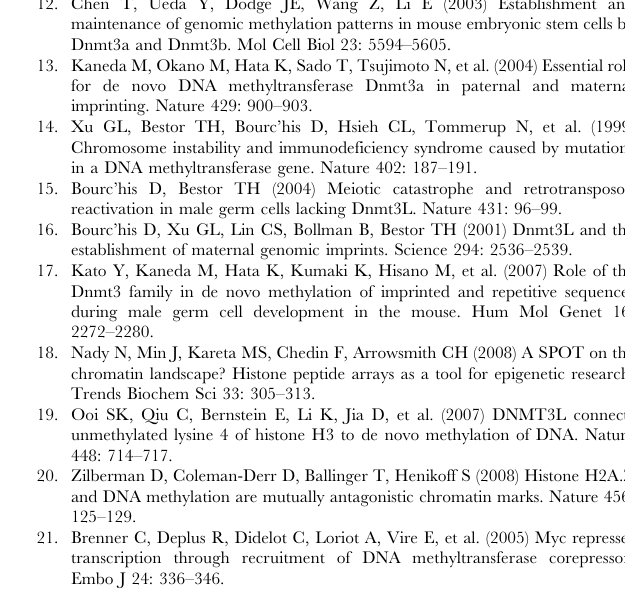
Figure S2 High and low methylation efficiency sites at the SNRPN test region (C-strand) conform to the sequence motifs defined for DNMT3A and DNMT3B at the pBR and Hygro test regions. High and low sites for DNMT3A show clear evidence for selection at the 2 2 and + 2 positions (highlighted in yellow) according to the predictive motifs defined for DNMT3A (top panel). Likewise, high and low sites for DNMT3B show clear evidence for selection at the + 1 position (highlighted in yellow) according to the predictive motifs defined for DNMT3B. Figure S3 A. This panel represents the DNA methylation patterns deposited by purified full-length DNMT3A2 enzyme in